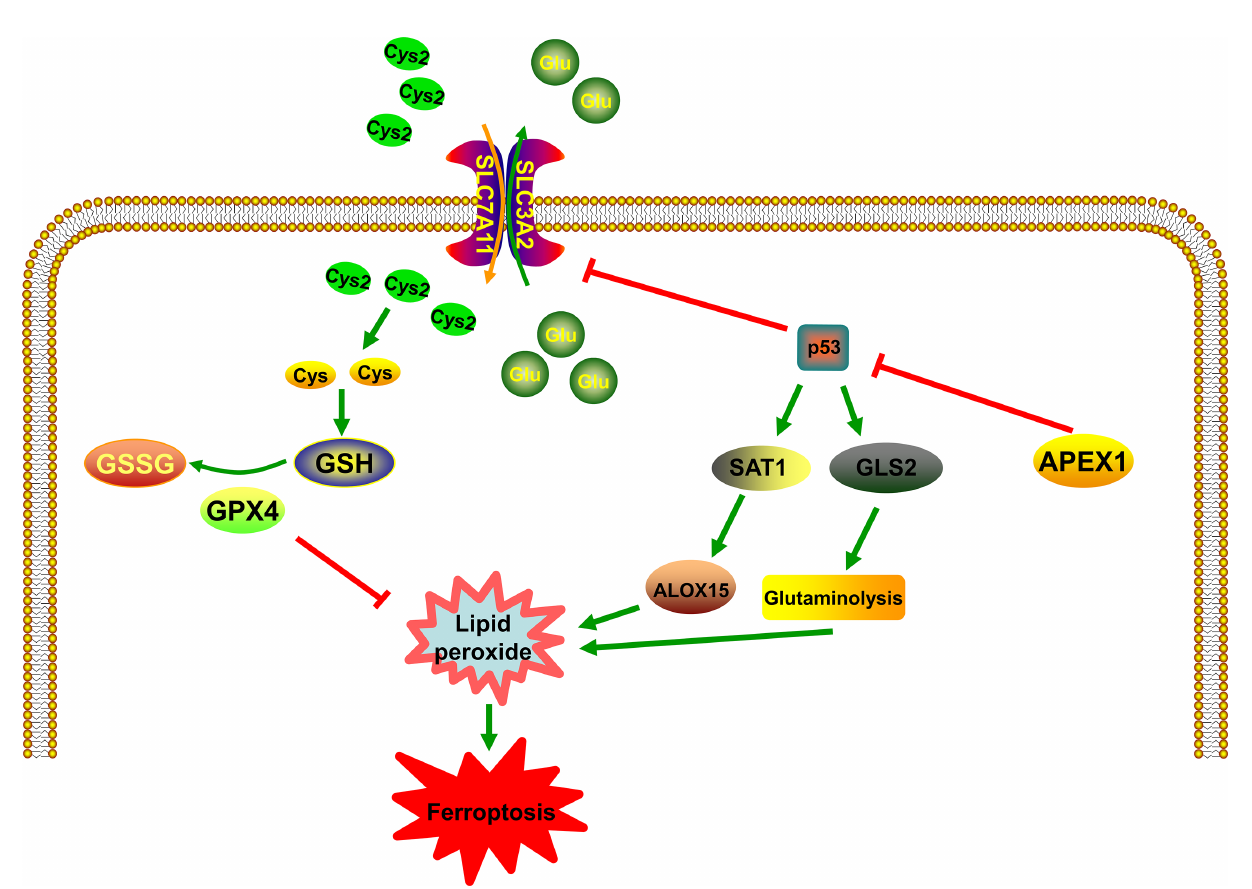
FIGURE 2 | The relationship between APEX1 and p53 in the control of ferroptosis. p53 plays an important role in the regulation of lipid peroxidation in ferroptosis. p53 can promote ferroptosis through the inhibition of system XC- expression or the induction of SAT1 and GLS2 expression. APEX1 is involved in the development of ferroptosis by regulating